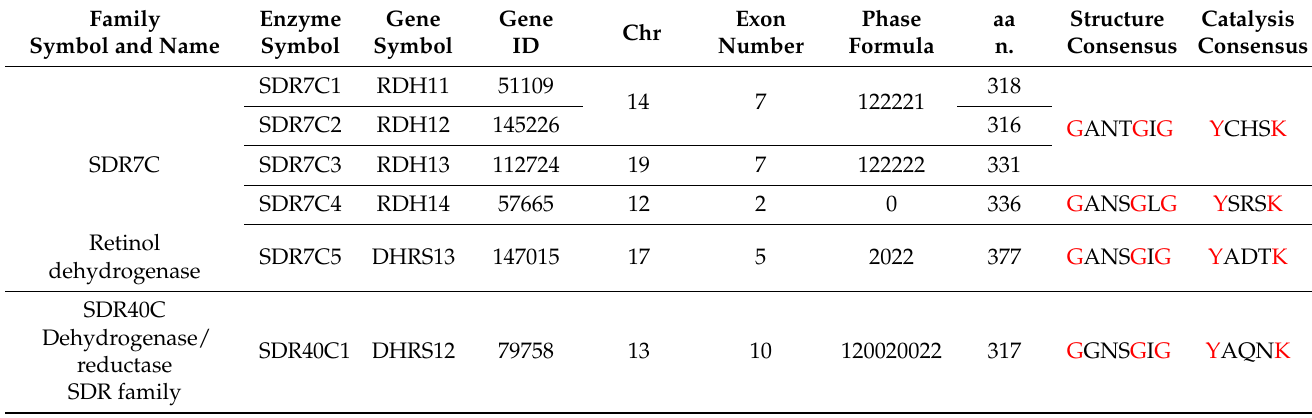
Table 1. Genetic and molecular data of the human SDR7C family and human SDR40C1 protein variants. Chr, chromosome; the variant phase formula includes phase type symbols aligned according to the sequence of their relative splicing sites; aa n., number of the variant amino acids; standard amino acids of the consensuses are in red.